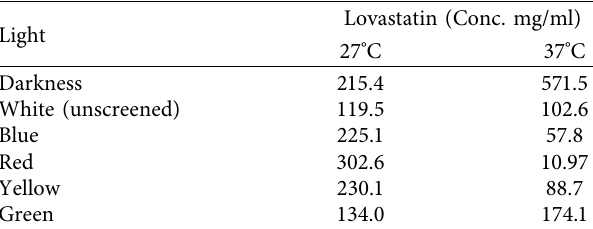
Table 4: Extracellular lovastatin concentrations (mg/ml) at 27 ° C and 37 °